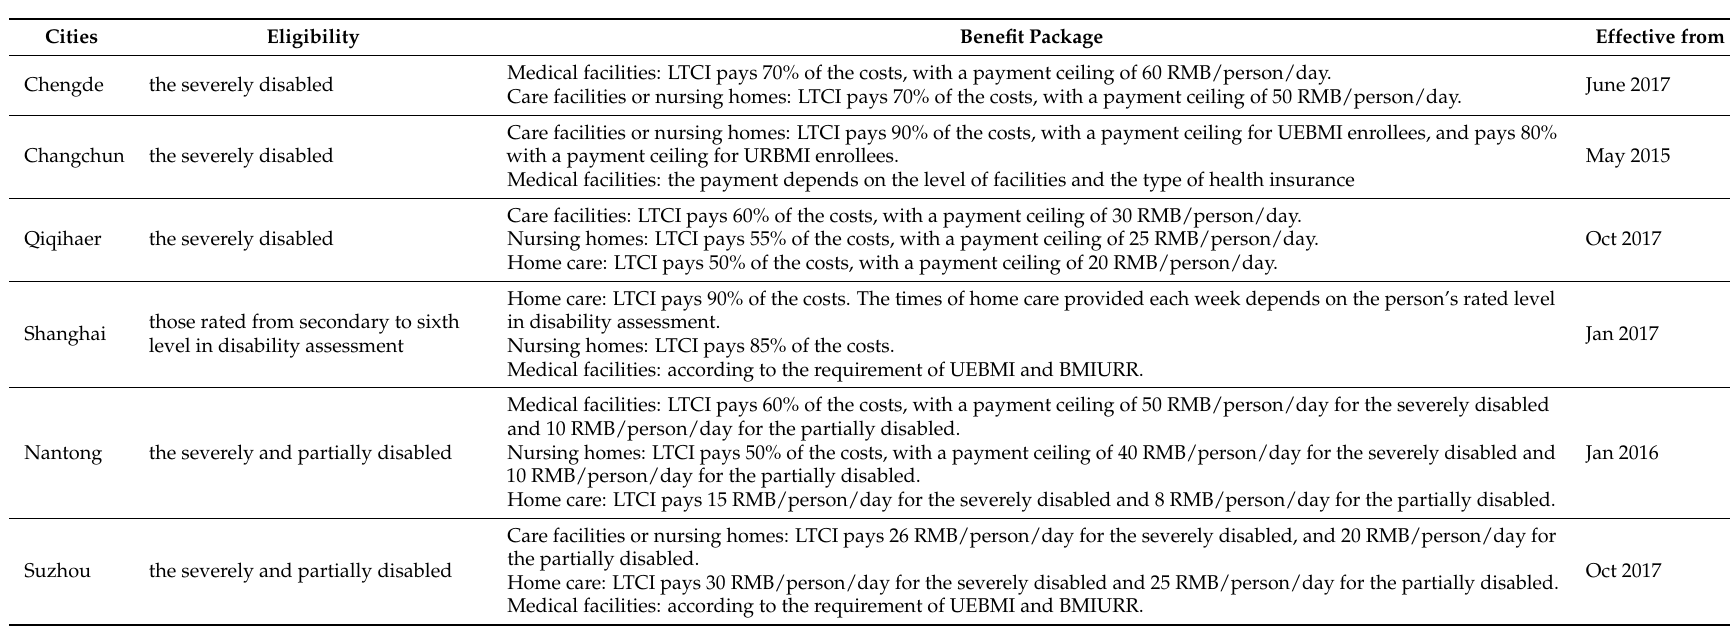
Table A4. Current LTCI policies in the pilot cities in China